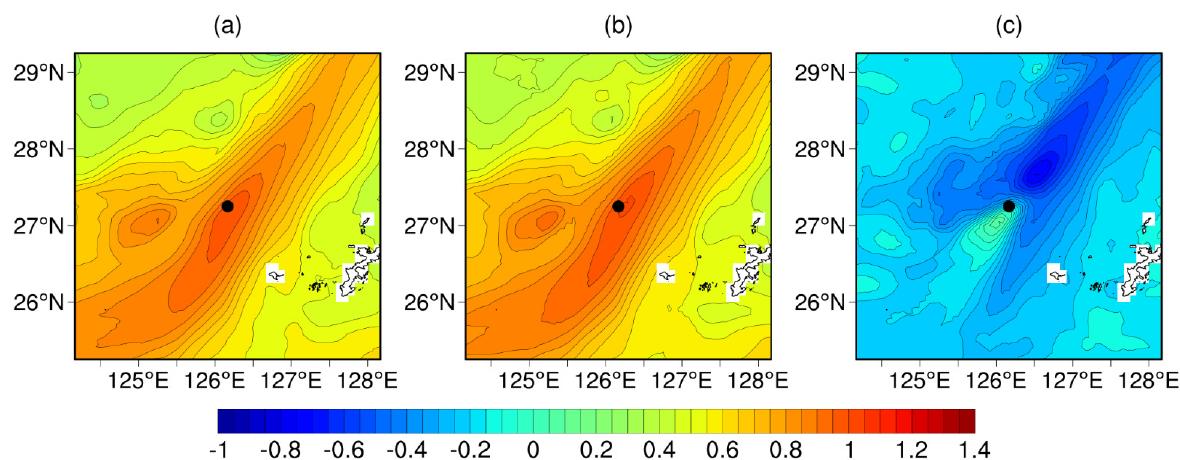
Figure 5. Distribution of the gain for group A on 1 January 2015, and the black dot in the figure is the observation point: ( a ) Kalman gain K at moment t in the EnOI scheme; ( b ) Kalman K 0 at moment t in the EnOS scheme; ( c ) gain K 1 acting at moment t in the EnOS scheme at historical moment t − 1 .